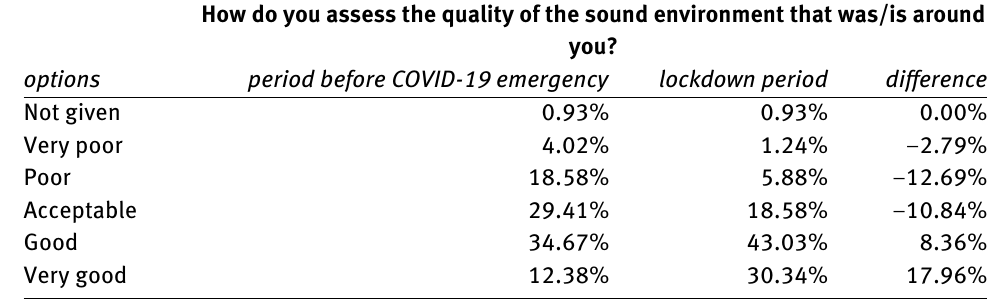
Table 13: Comparison between the lockdown period and the period before COVID-19 emergency regarding the assessment of soundscape How do you assess the quality of the sound environment that was/is